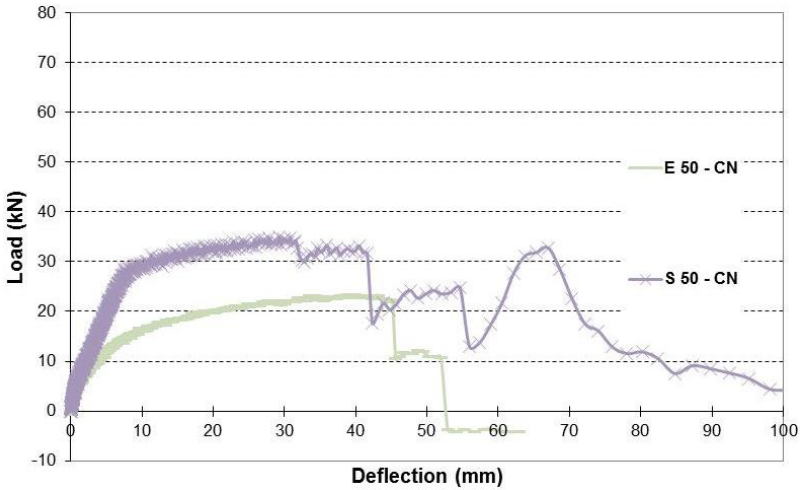
Figure 17. Load-deflection of beams with 50% corrosion levels (No repair).